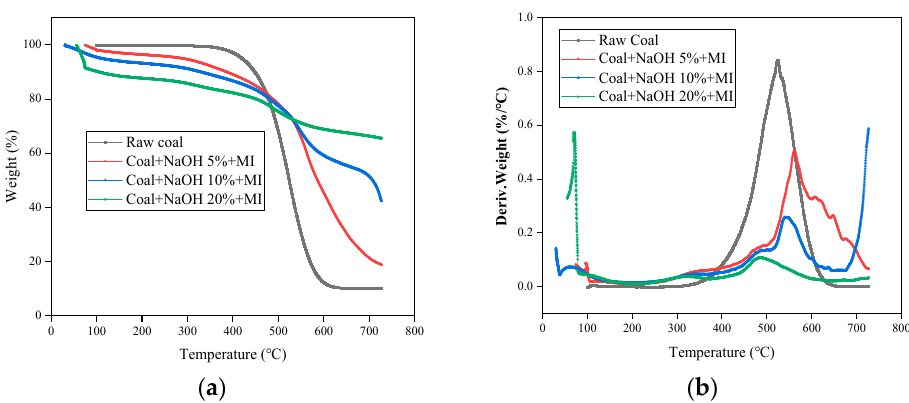
Figure 3. TG ( a ) and DTG ( b ) curves of coal sample treated by microwave combined with different concentrations of sodium hydroxide solution.